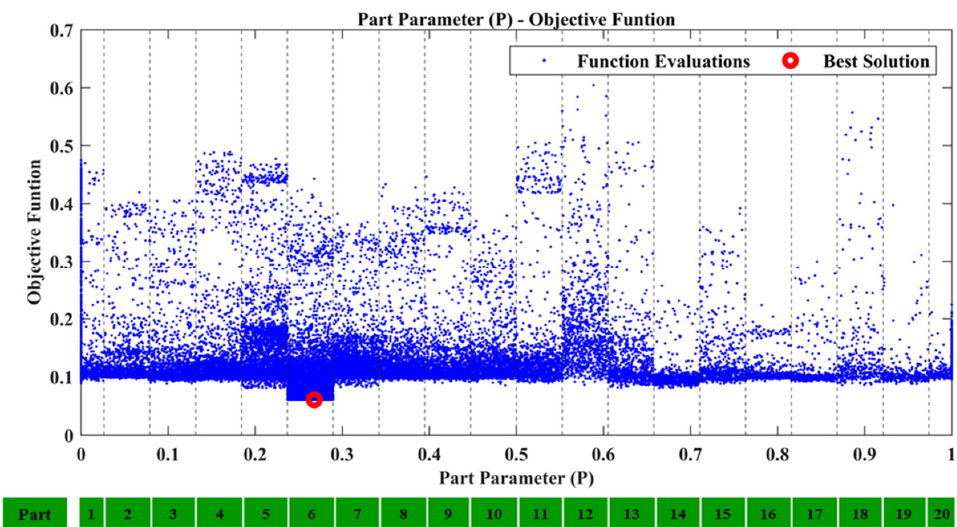
Figure 10. Case 1: Part parameter ( P ) versus the Objective Function values.